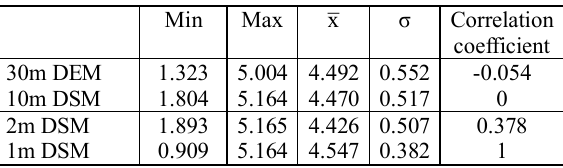
Table 4. Descriptive statistics of the comparisons of the solar radiation models for